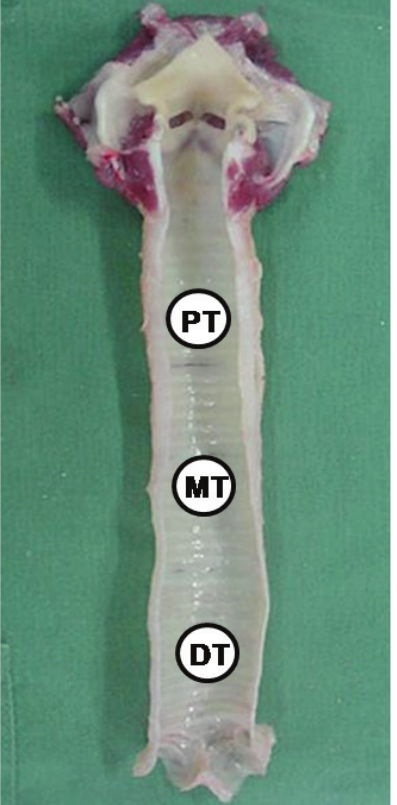
FIGuRE 1 - Tracheal mucosa biopsy areas ( PT – proximal trachea, MT – medial trachea, dT – distal